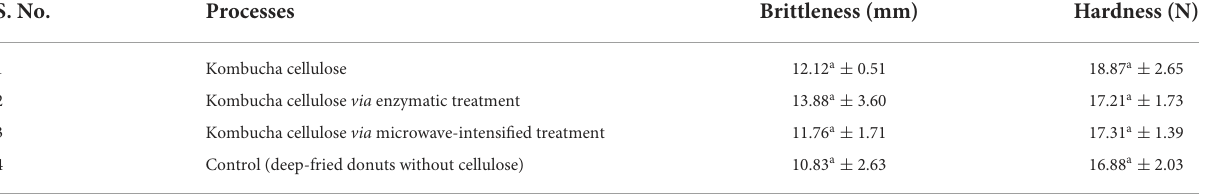
TABLE 4 Brittleness * and hardness * of deep-fried donuts made using various techniques. S.